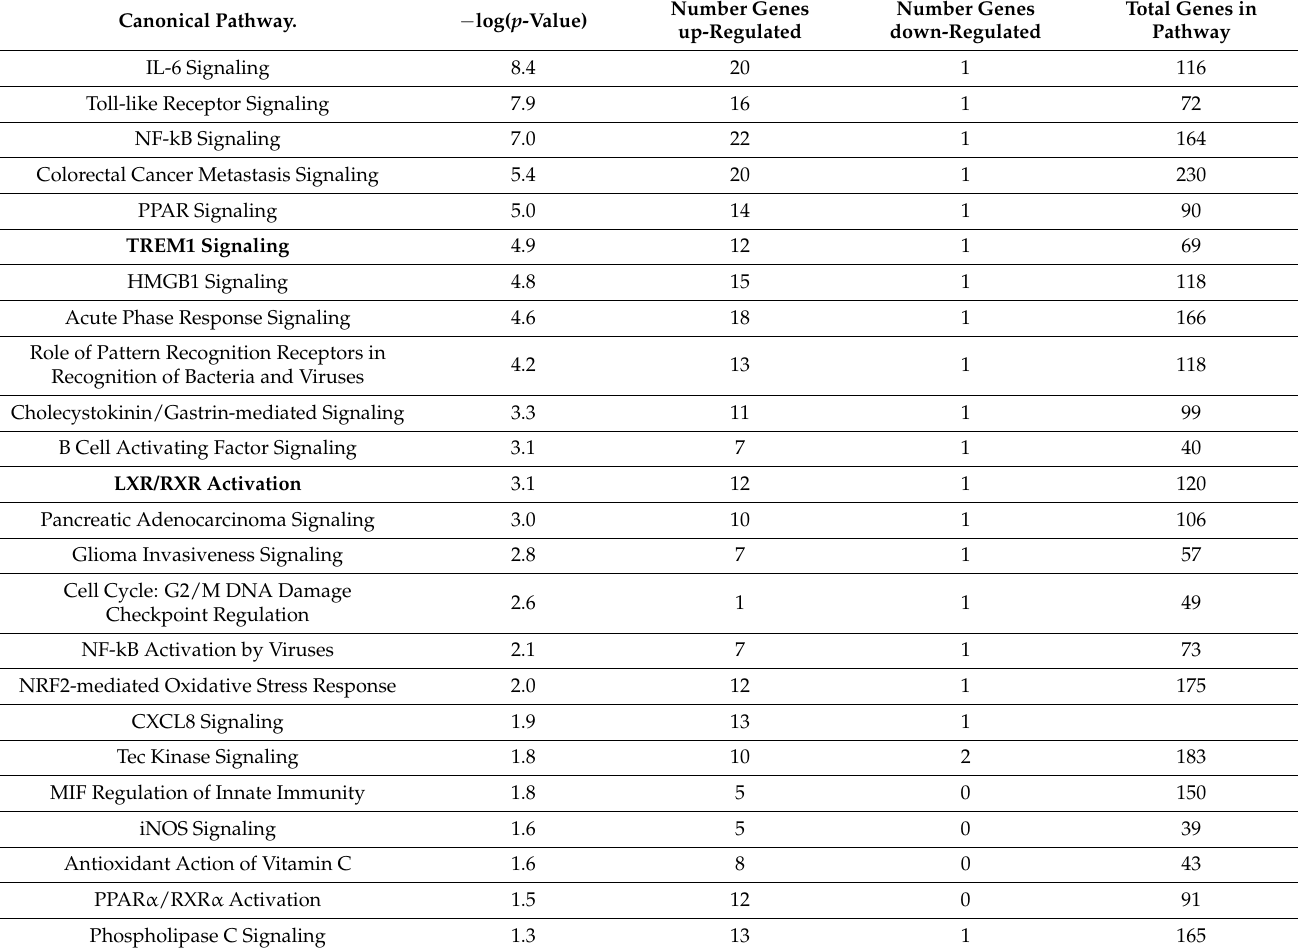
Table 7. Significantly ( p < 0.05) enriched canonical pathways which respond to WT S. marcescens stimulus. Canonical